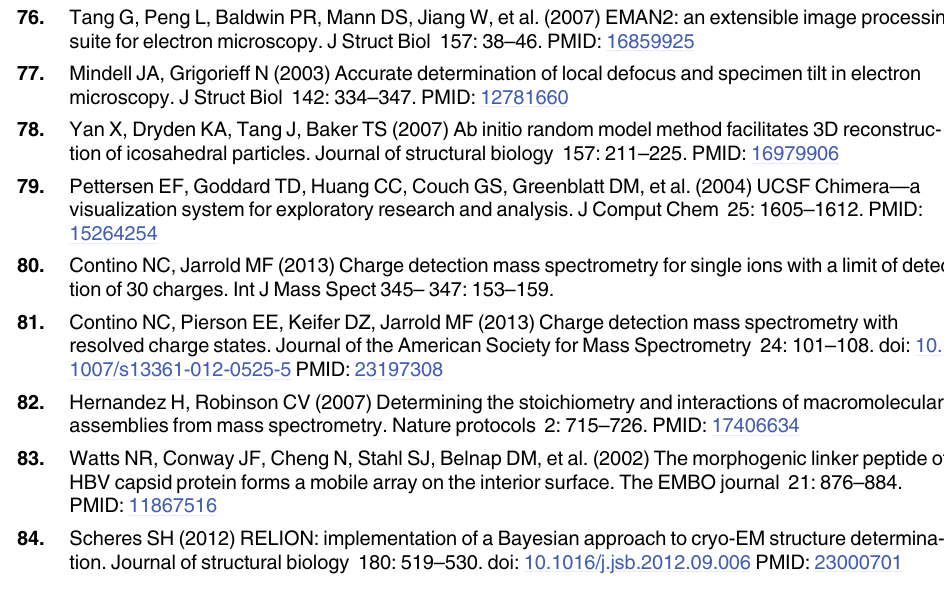
PLOS Pathogens | DOI:10.1371/journal.ppat.1005802 August 12,